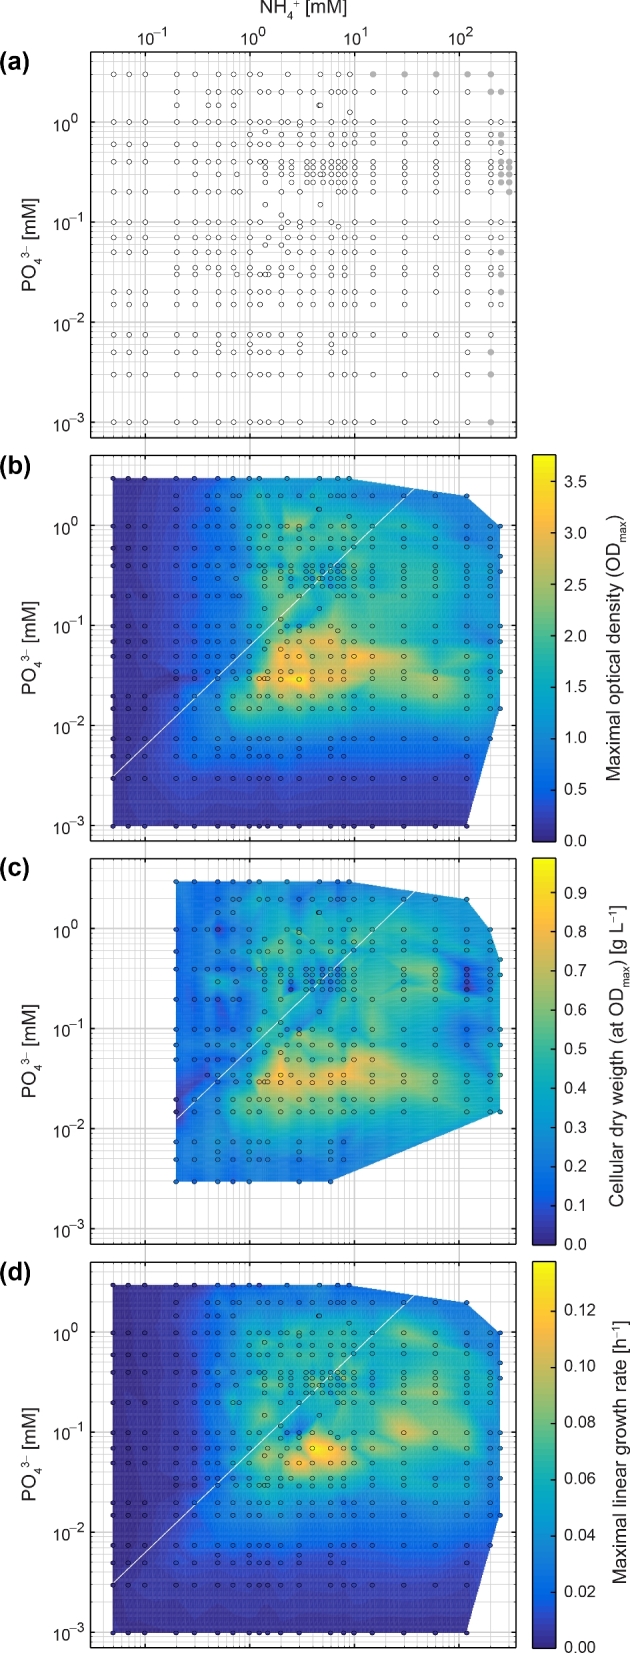
Growth of P. inhibens with varying concentrations of NH4+ (50 μM to 250 mM) and PO43− (1 μM to 3 mM). Glucose (sole source of carbon and energy) was in each case provided at the same initial concentration (11 mM). NH4+ and PO43− concentrations are plotted in logarithmic scale, growth parameters in colored linear scales. (a) Grid display of the analyzed 415 different concentration pairs of NH4+ and PO43− that correspond to 207 different N:P supply ratios ranging from 10–2 to 105. Filled gray circles indicate concentrations where growth was not observed. Colored data maps display the (b) maximal optical density (ODmax) reached upon entry into stationary growth phase, (c) the attained cellular dry weight at ODmax and (d) the calculated maximal growth rate (μlin) during linear growth (representing the major active growth phase) for each concentration pair of NH4+ and PO43−. The diagonal white line represents the canonical Redfield N:P ratio of 16:1. The circles in subfigures b–d represent experimentally determined values and colored areas between these data points were retrieved by linear interpolation. See Fig. 3 for analyzed growth parameters as a function of NH4+ or PO43− concentration. Corresponding growth curves with fitted logistic dose–response (LDR) function are compiled in Fig. S2 (Supporting Information).